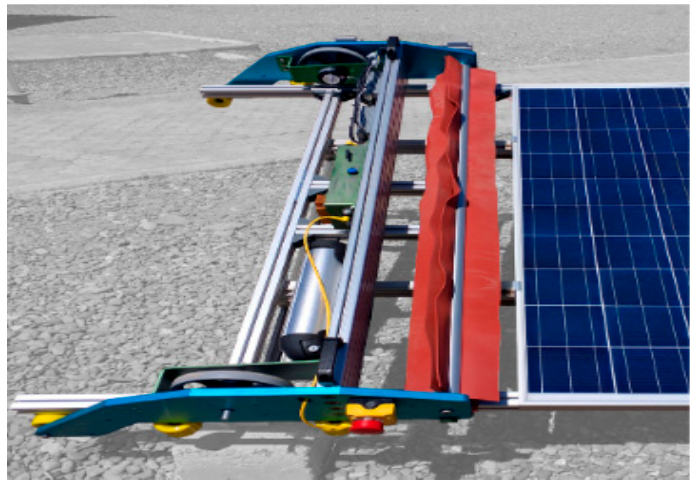
Figure 3. Robotic cleaning system [20].